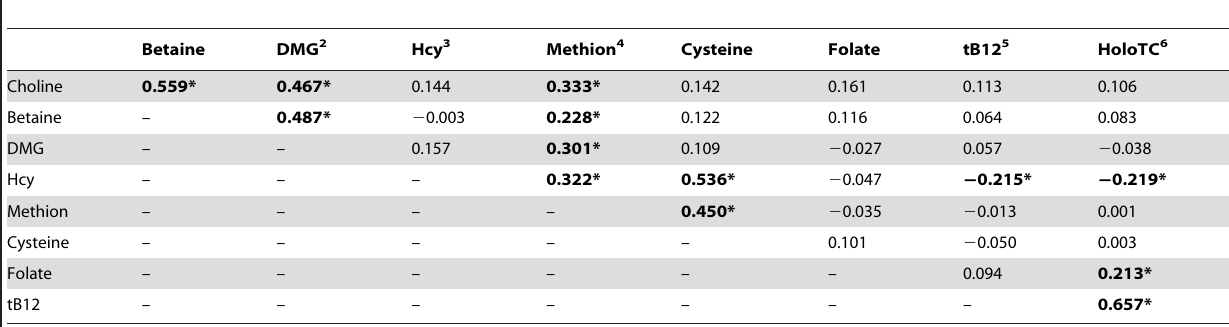
Table 2. Correlation coefficients among plasma methyl nutrient and metabolites, folate and vitamin B12 1